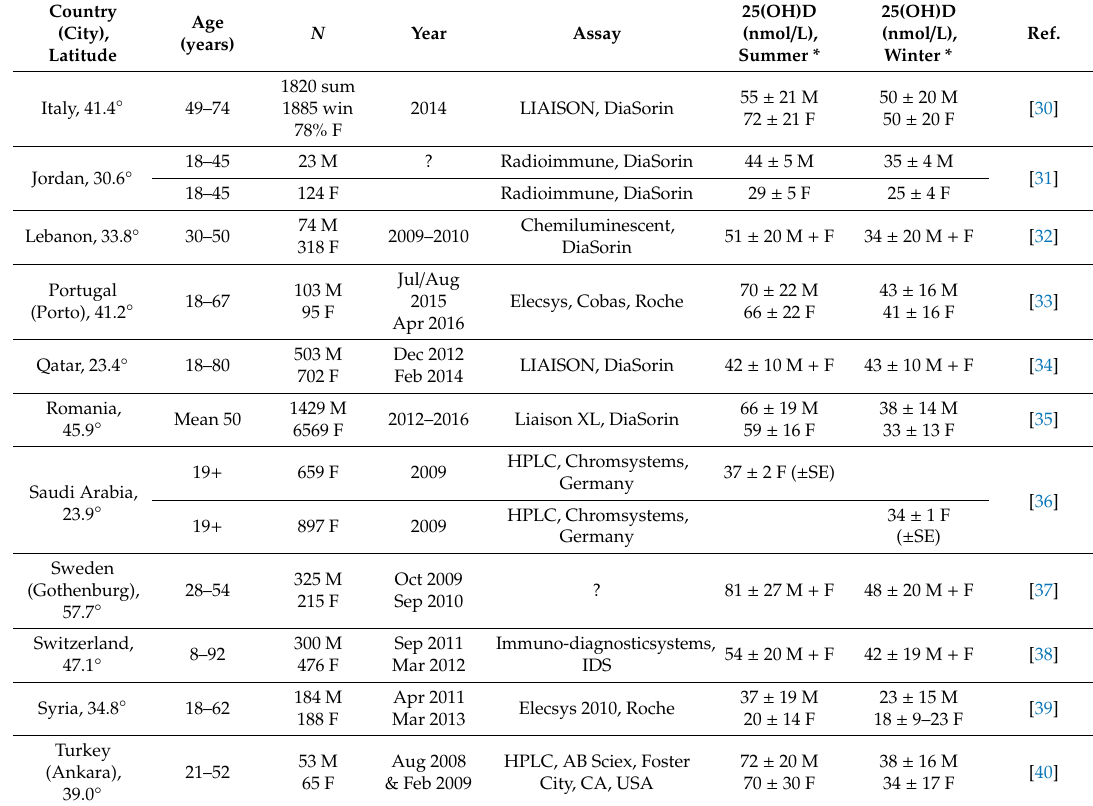
*, mean, standard deviation; ELISA, enzyme-linked immunosorbent assay; F, female; HPLC, high-performance liquid chromatography; M, male; SE, standard error; su, summer; wi, winter; for Germany, numbers in parentheses are 95% confidence intervals. Table 2. Dietary supply data for the 12 Middle East and European countries with data available from the Food and Agriculture Organization